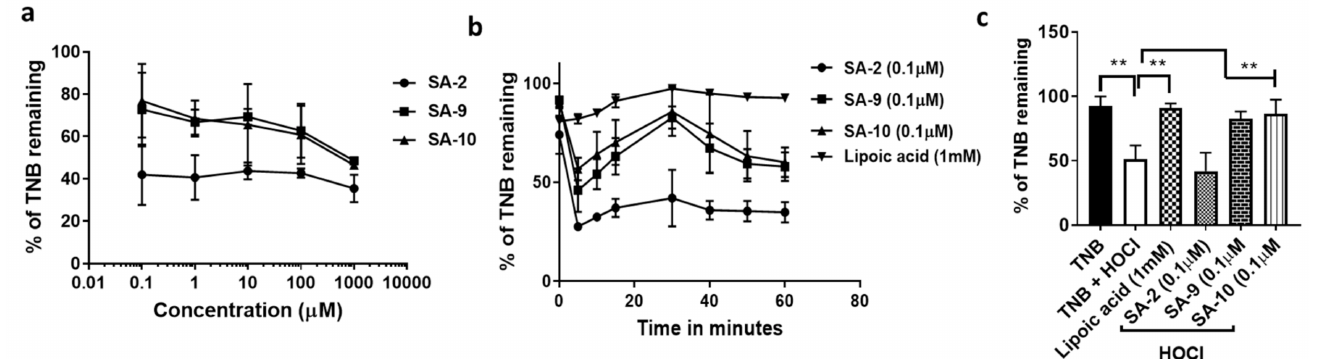
Figure 3. The HOCl scavenging activity of SA compounds in buffer solution. ( a ) Addition of oxidant HOCl to TNB decreased the % of TNB to ~50% as measured by absorbance at 520 nm. Addition of compounds at different concentrations (0.1 µ M, 1 µ M, 10 µ M, 100 µ M, and 1000 µ M) of SA compounds SA-2 , SA-9 , and SA-10 rescued the decrease in fluorescence of TNB measured at 30 min, which is proportional to the HOCl scavenging activity. ( b ) Addition of compounds at 0.1 µ M rescued the decrease in fluorescence of TNB measured at different time points, which is proportional to the HOCl scavenging activity. Lipoic acid (1 mM) was used as positive control. ( c ) The % of TNB remaining after 30 min of addition of HOCl to the wells containing lipoic acid, SA-2, SA-9 , and SA-10 . n = 4, ** p < 0.001. One-way ANOVA, Graph Pad